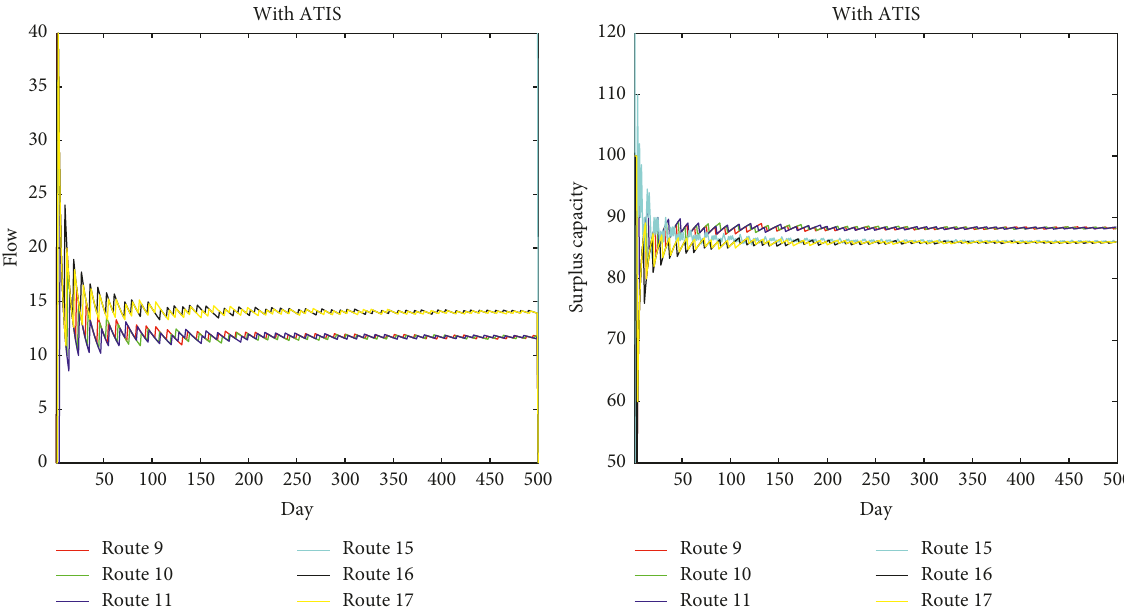
Figure 10: Evolutionary trajectories of route flows (a) and route surplus capacity (b) for travellers in the second group. Table 12: Route flow and perceived cost in mixed equilibrium for travellers in the third